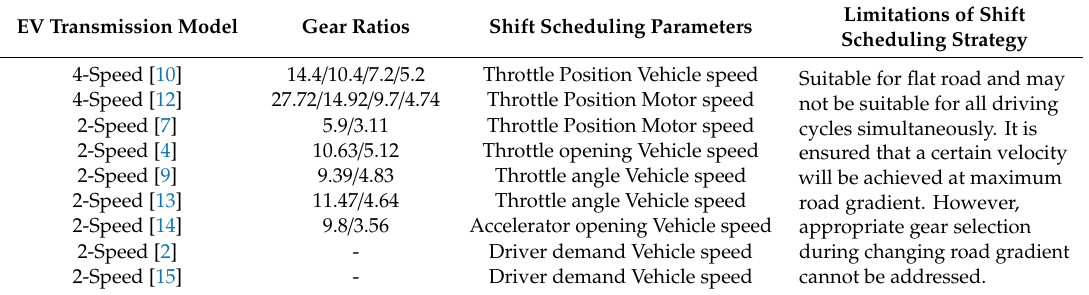
Table 1. Gear shift scheduling parameters considered in recent studies on the multi-gear transmission system in